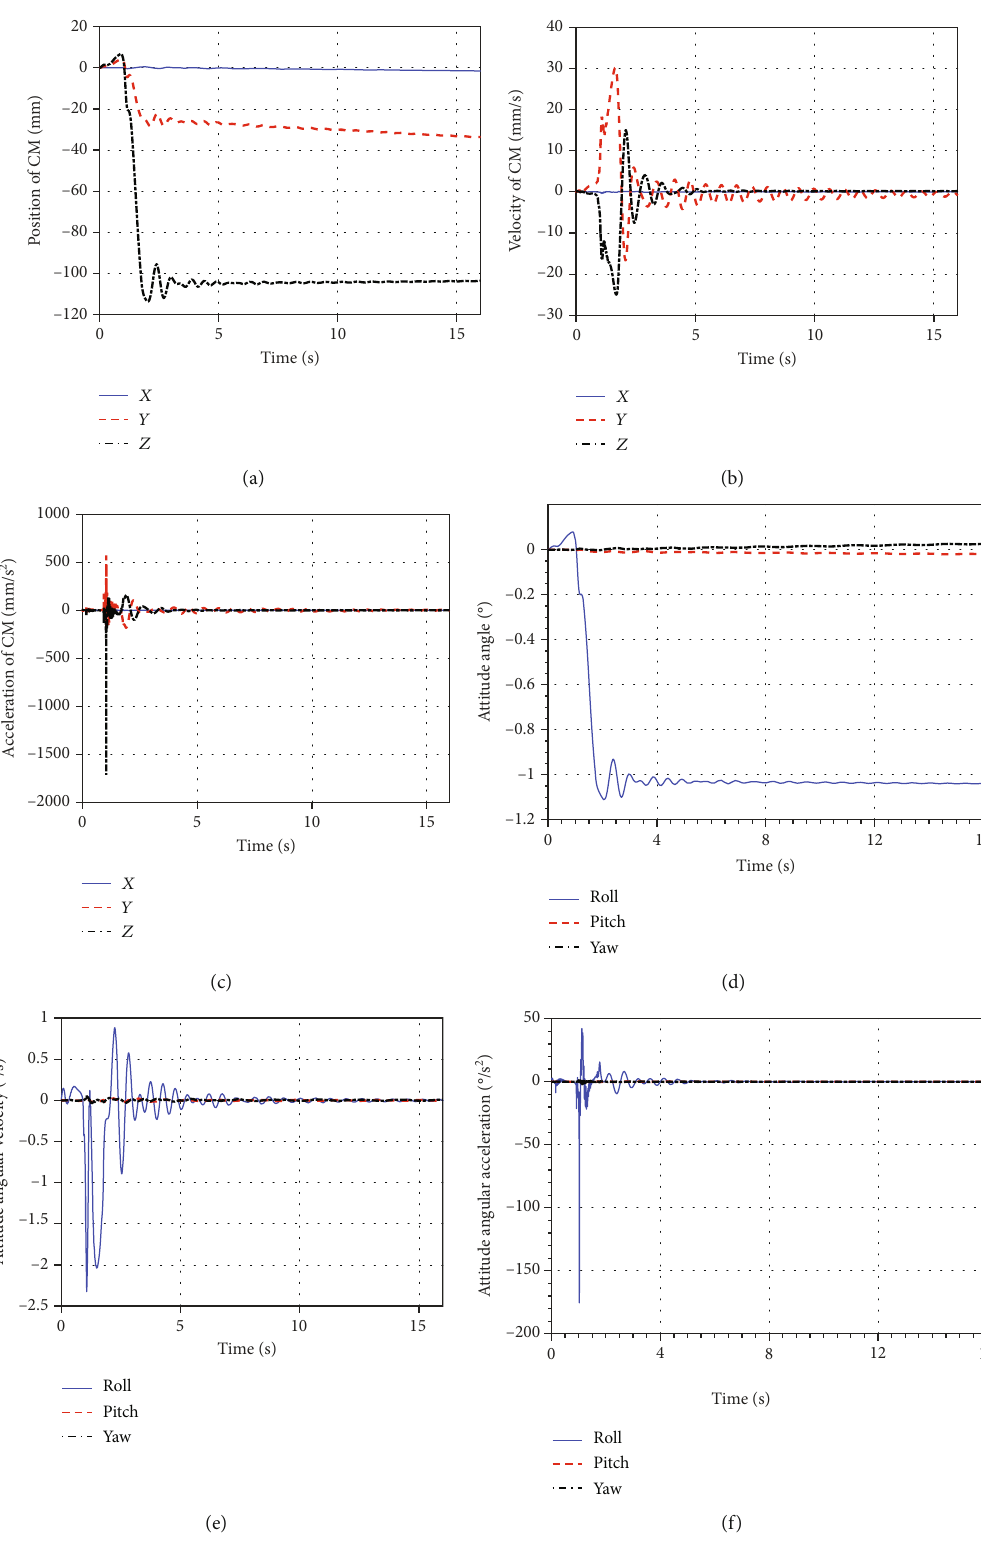
Figure 12: Simulation results of the system on orbit. (a) The displacement curve of the satellite centroid. (b) The velocity curve of the satellite centroid. (c) The acceleration curve of the satellite centroid. (d) The attitude angle of the satellite. (e) The attitude angular velocity of the satellite. (f) The attitude angular acceleration of the